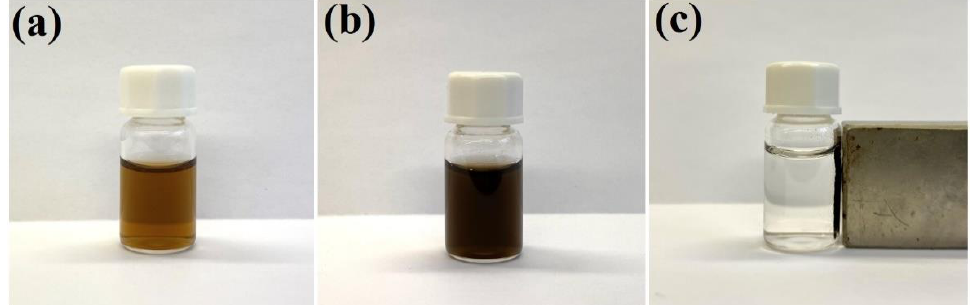
Figure 1. Photographs of: ( a ) the sol of silver nanoparticles (before mixing with the sol of Fe 3 O 4 nanoparticles), ( b ) the mixture of the sol of Ag nanoparticles and the sol of Fe 3 O 4 nanoparticles after sonication and shaking for 45 min, and ( c ) the sol of (Fe 3 O 4 @Ag)@SiO 2 nanostructures after application of a strong external magnetic field. The used vessel has a volume of 2 mL. The sols were not diluted before the photo was taken.